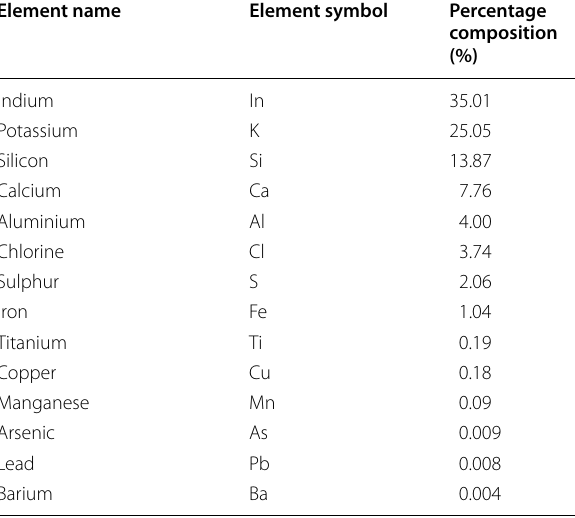
Table 1 Musa spp. fibre elemental compositions